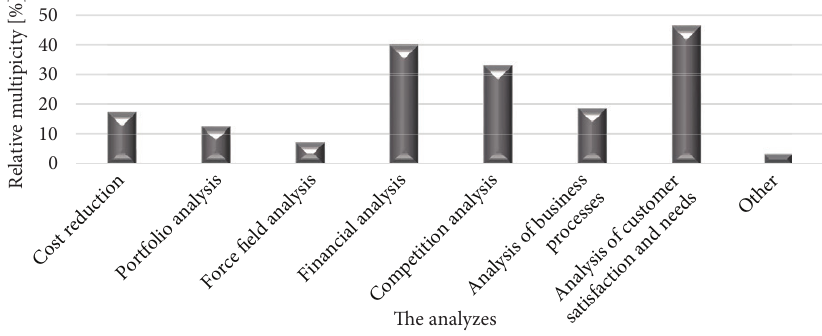
Figure 6. The analyses before implementing changes (source: own